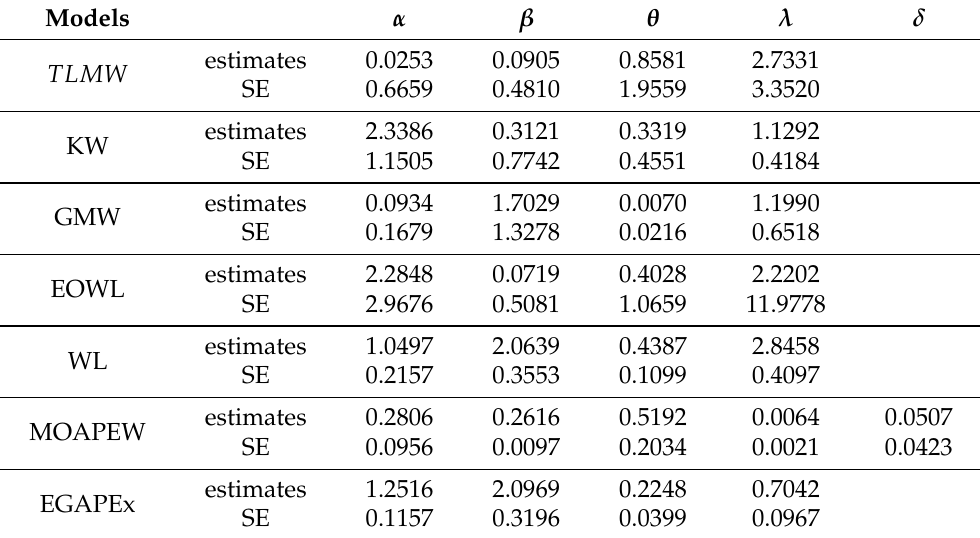
Table 15. MLE for parameters of TLMW and comparative models for waiting